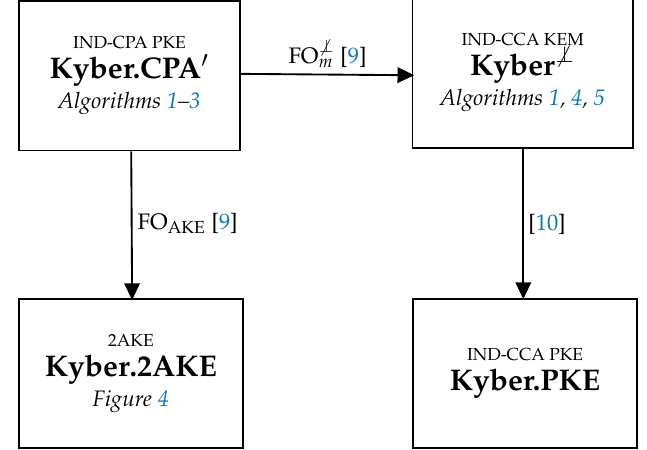
Figure 3. Kyber and derived